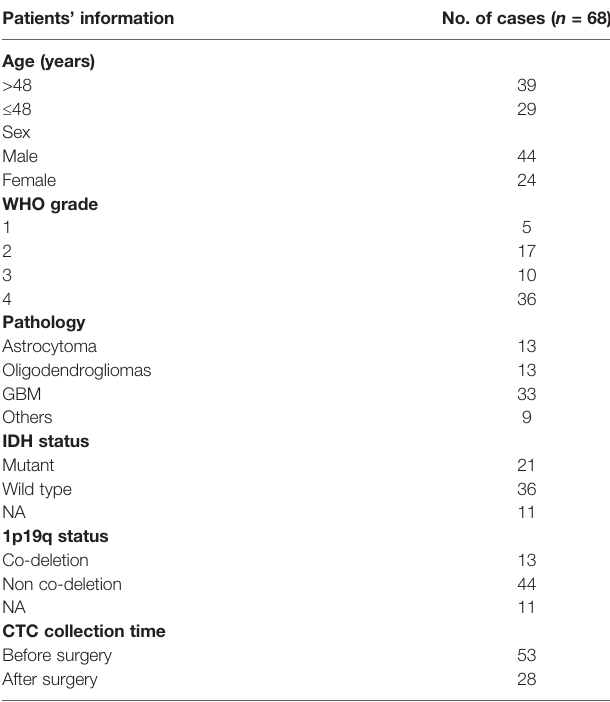
TABLE 1 | Baseline information of